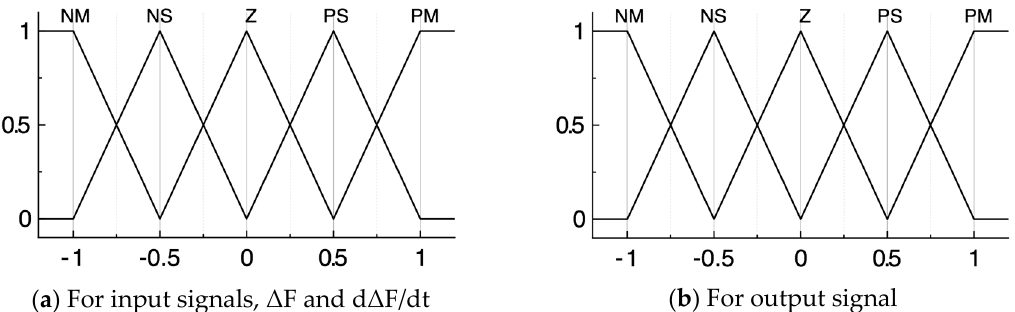
Figure 11. Membership function of the fuzzy logic controller of the BESS.